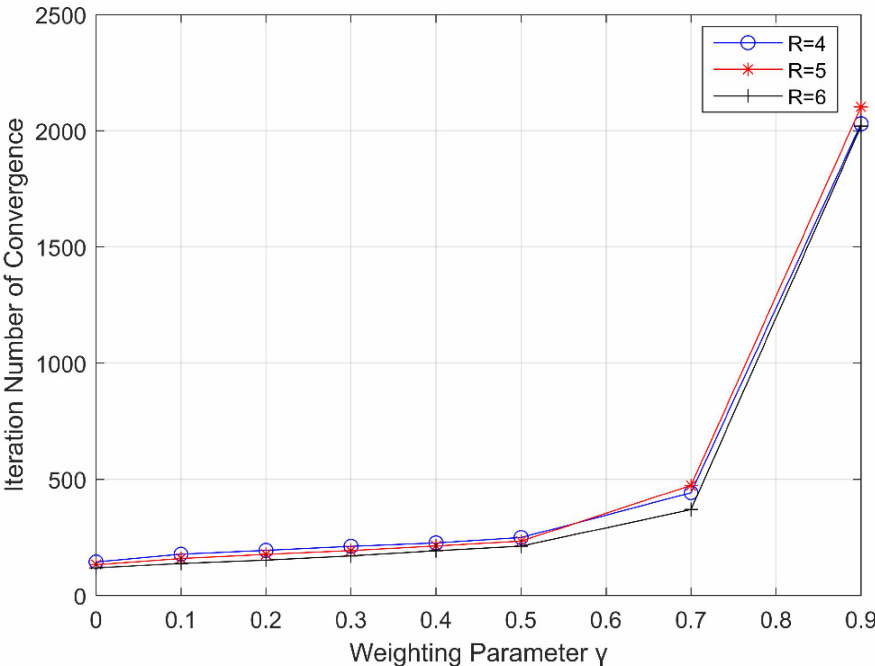
Figure 10. Number of iterations for each trail of the proposed method as a function of weighting parameter γ with real rank R = 4, 5, and 6, SNR = 20 dB, λ = 10 − 4